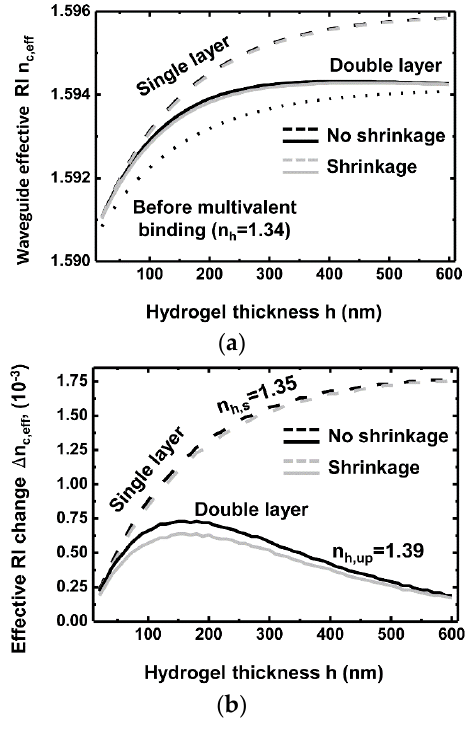
Figure 4. Cont. Figure 4.